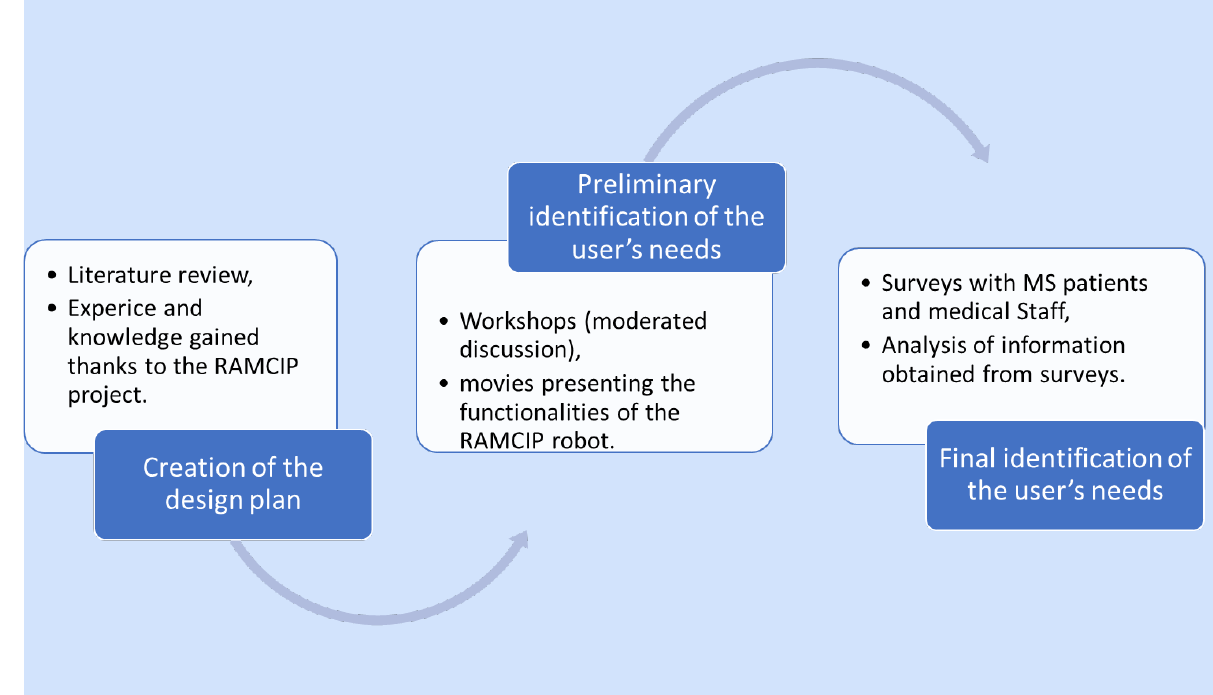
Figure 3. The study design flow chart.